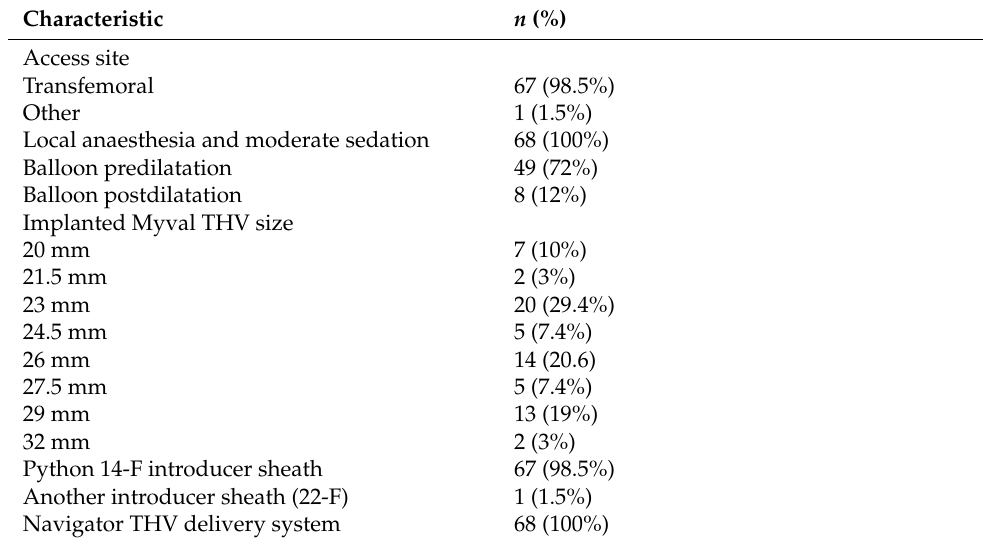
Table 2. Procedural characteristics of TAVI using Myval THV in patients with BAV.